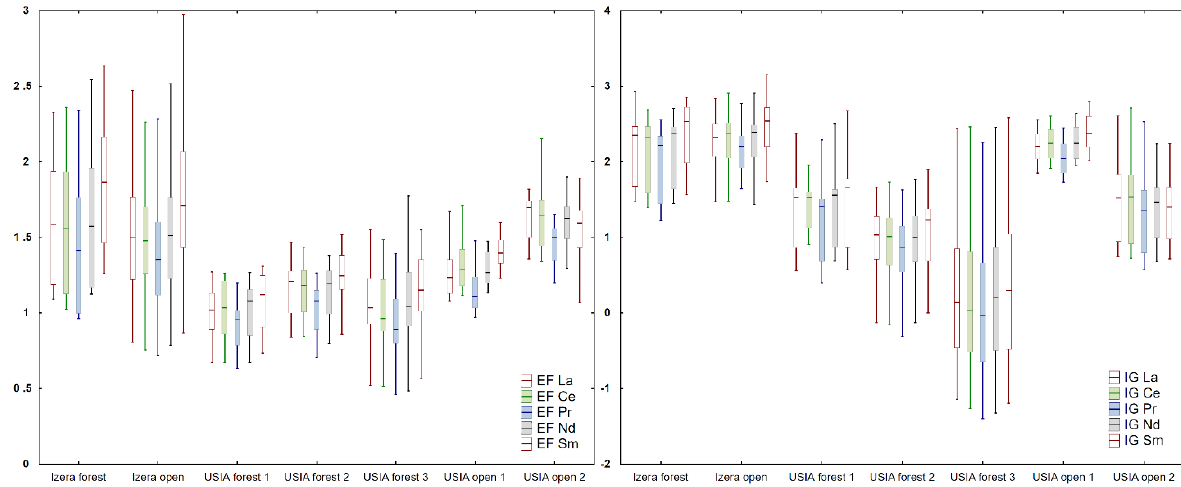
Figure 2. Box and whisker plots (whiskers: min-max, box: upper and lower quartile, line: median) of IG and EF of light REEs, La, Ce, Pr, Nd, and Sm.